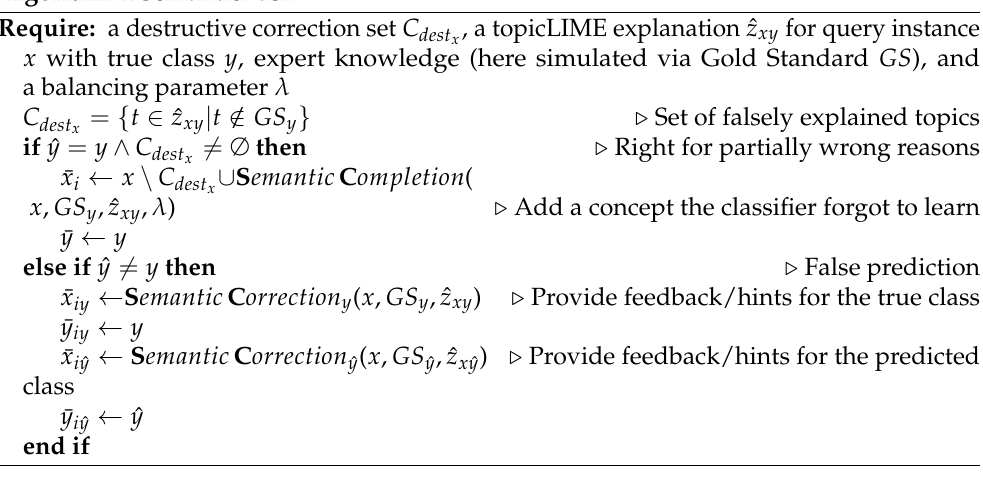
Algorithm 3 S emantic C